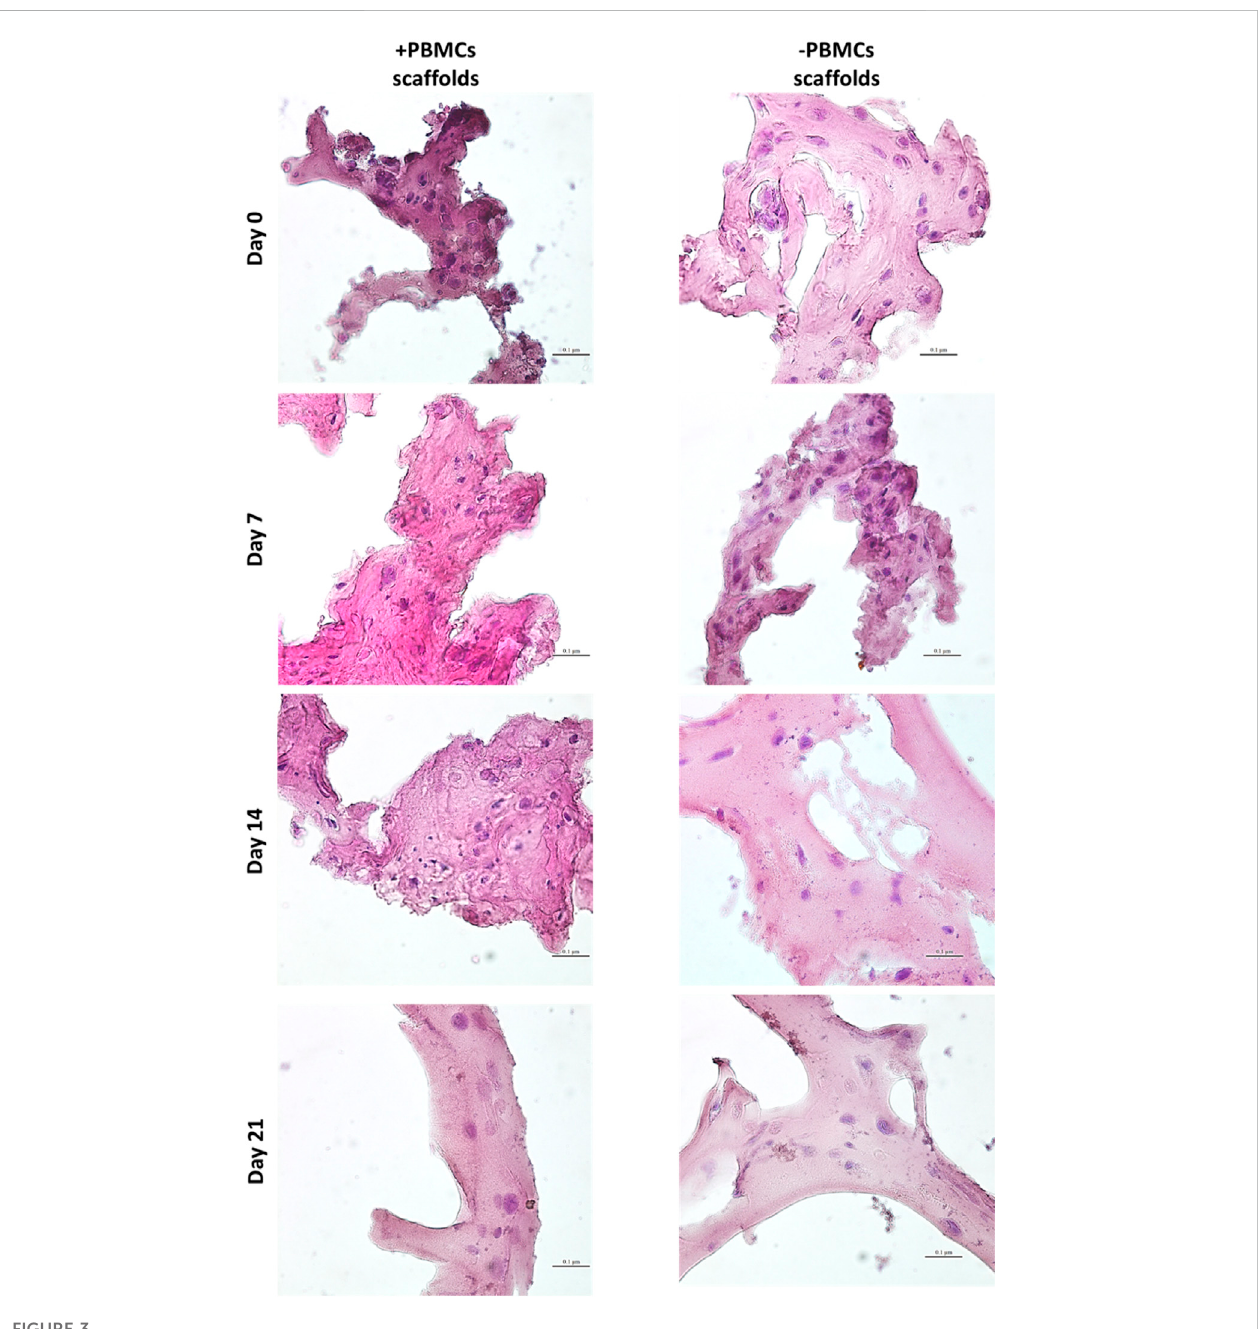
FIGURE 3 Hematoxylin & Eosin staining on 3D fi brin scaffolds embedded with h BM-MSCs- h SkMs with and without PBMCs. Images were acquired at day 7, 14 and 21 at ×40 magni fi cation, scale bar: 20 µm.